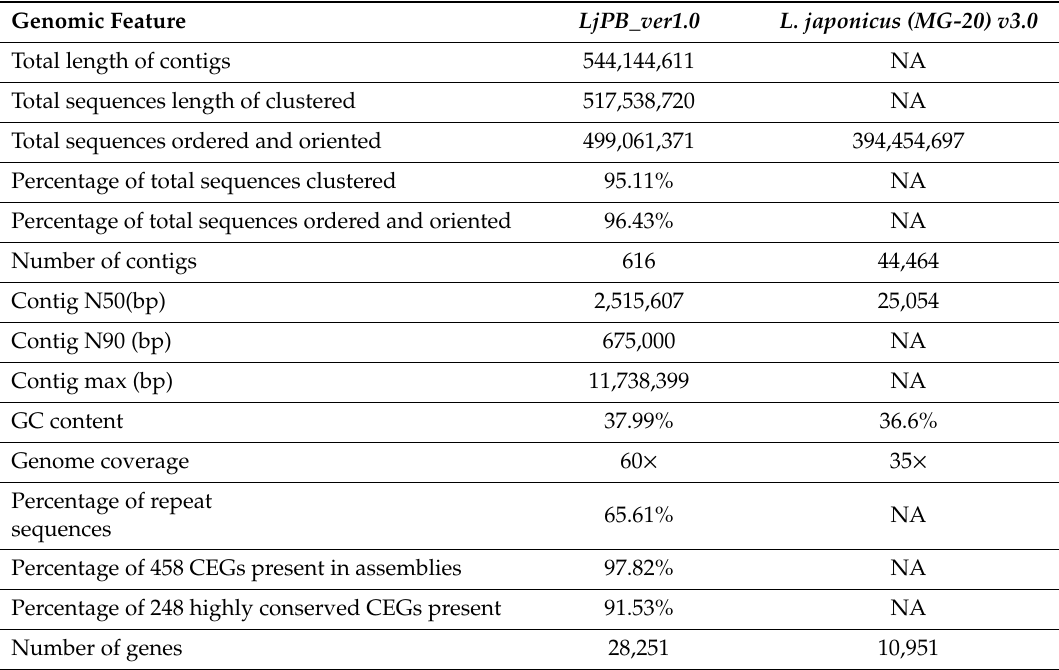
Table 1. Summary of genome assembly and comparison with previous assembly L.j